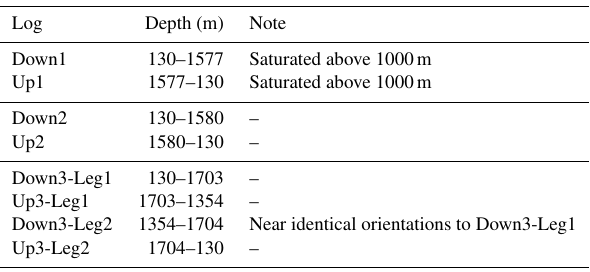
a final depth of 1751 m (Winski et al., 2019), surpassing the original 1500 m goal.